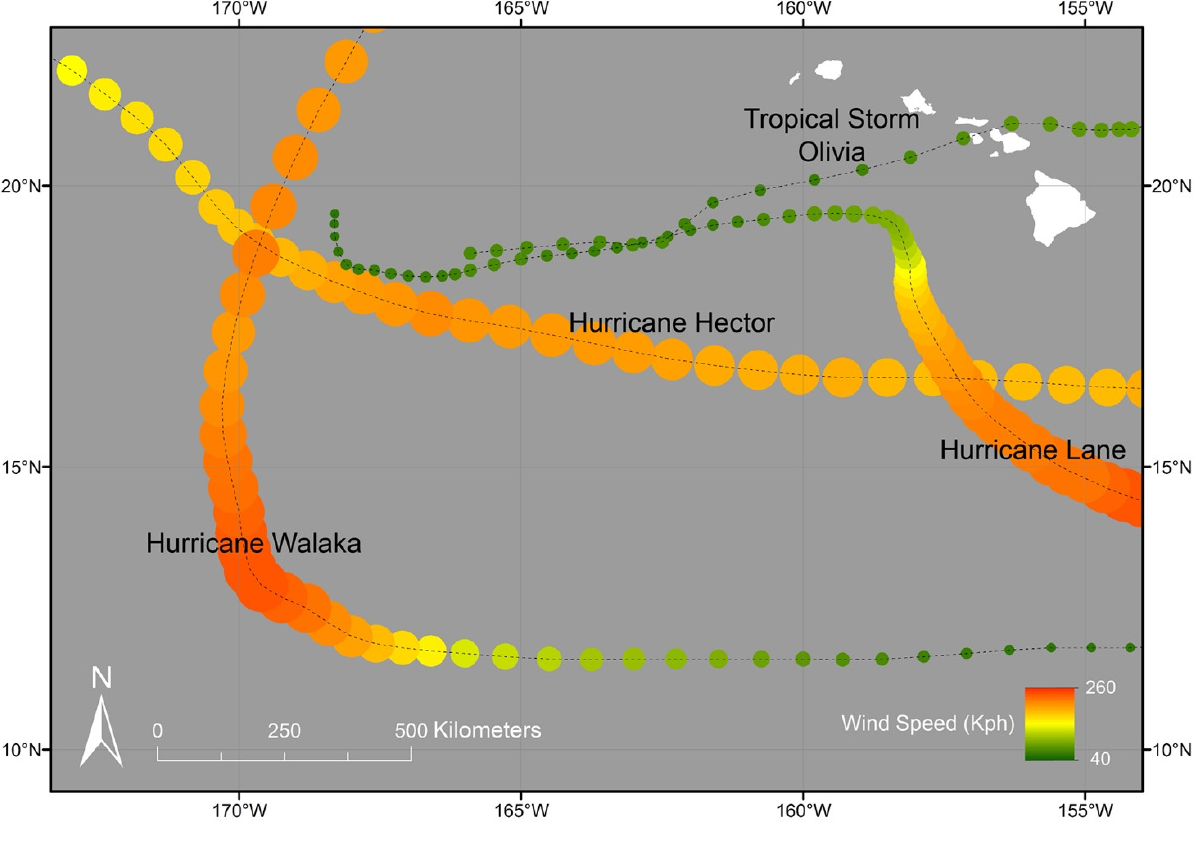
Figure 3. Tropical cyclone activity during the 2018 Central Pacific Hurricane Season, which included four named storm systems that directly impacted the study area. Wind speeds along each storm track are symbolized according to point size and color